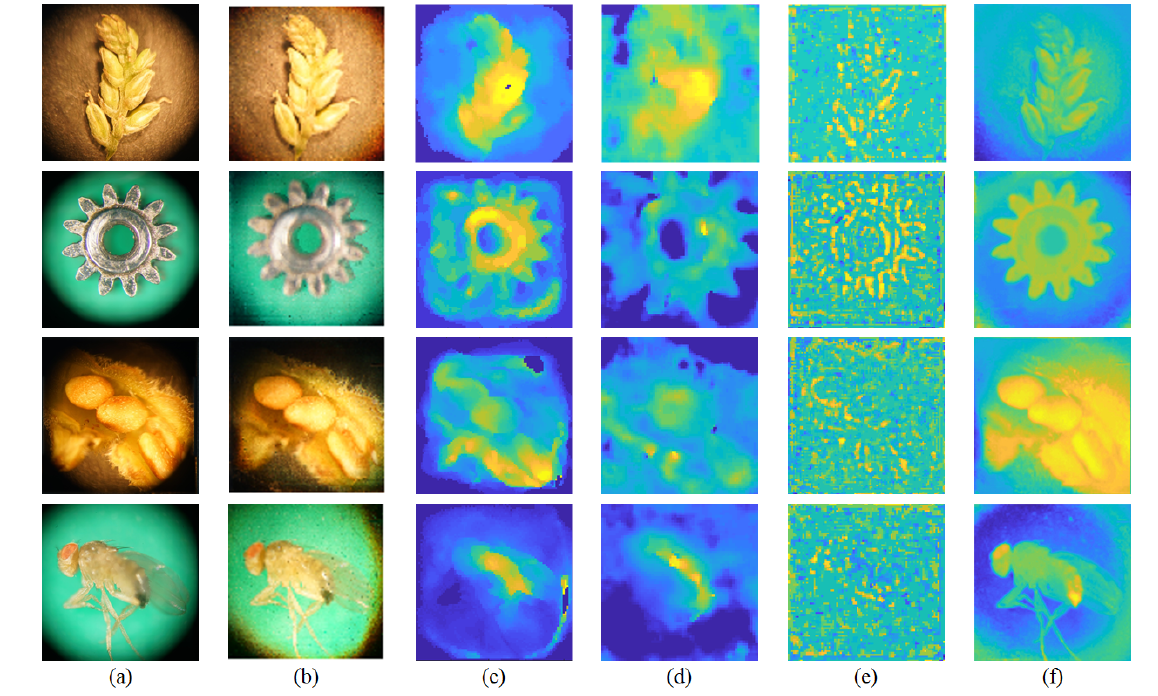
Figure 7. Results of estimated depth information for LF images; ( a ) high-resolution 2D images, ( b ) central-view images, ( c ) correspondence analysis-based method, ( d ) EPINET, ( e ) focus analysis- based method, and ( f ) proposed method.